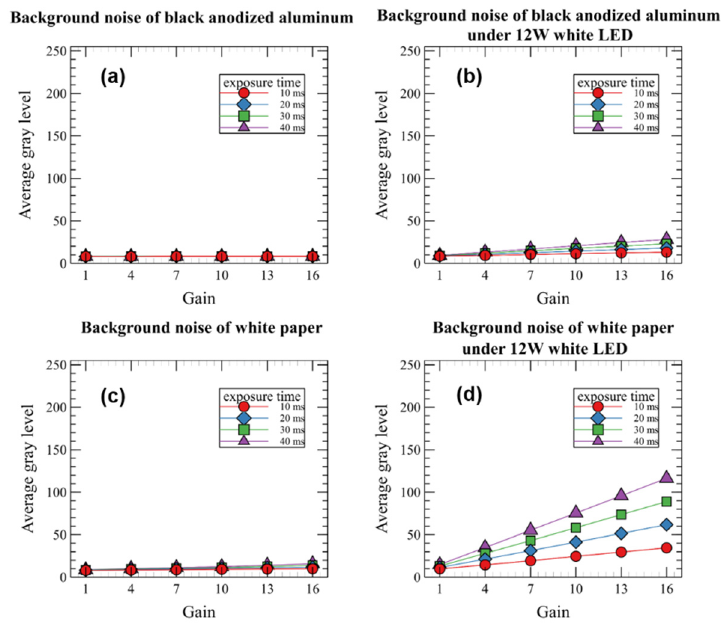
Figure 7. Background noise of black-anodized aluminum plate ( a , b ) and white paper ( c , d ) with and without 12 W white LED illumination according to the exposure time and gain of the camera.